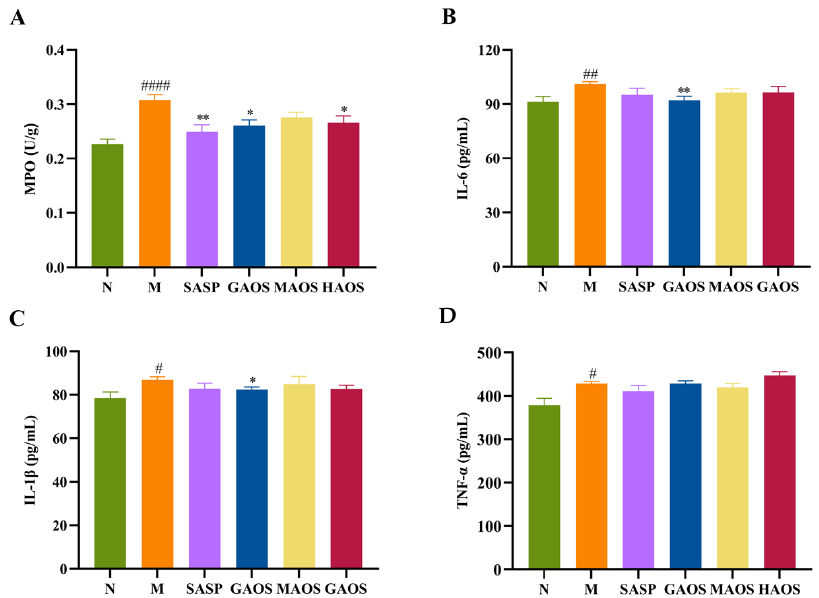
Figure 2. Effect of alginate oligosaccharides on inflammatory responses in mice with DSS-induced colitis. ( A ) MPO activity. ( B ) IL-6. ( C ) IL-1 β . ( D ) TNF- α . Data were mean ± SEM ( n = 8). # p < 0.05, ## p < 0.01, #### p < 0.0001 vs. the N group; * p < 0.05, ** p < 0.01 vs. the M group.